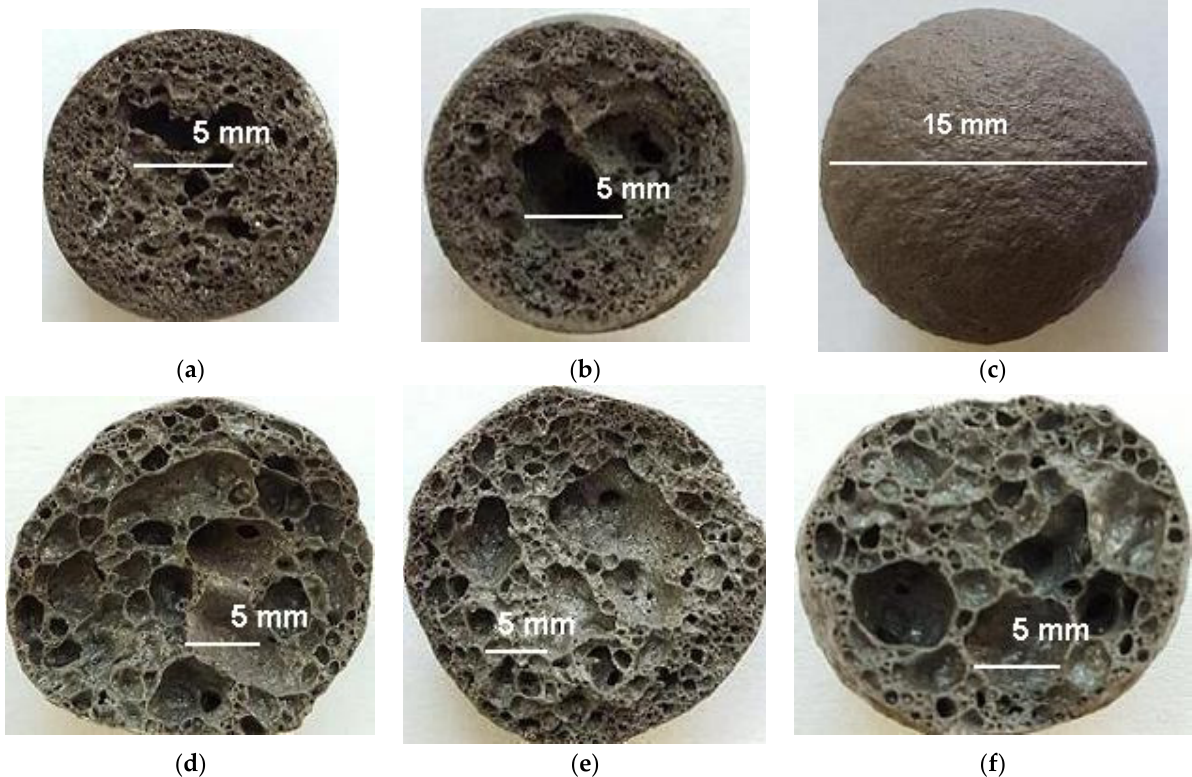
16 of 20 Figure 12. XRD pattern of the CB31 mixture fired at a temperature of 750 ° С : M—mullite; K—crystobalite; S—calcium ‐ magnesium silicates; N—sodium ‐ calcium silicates; A—anorthite.